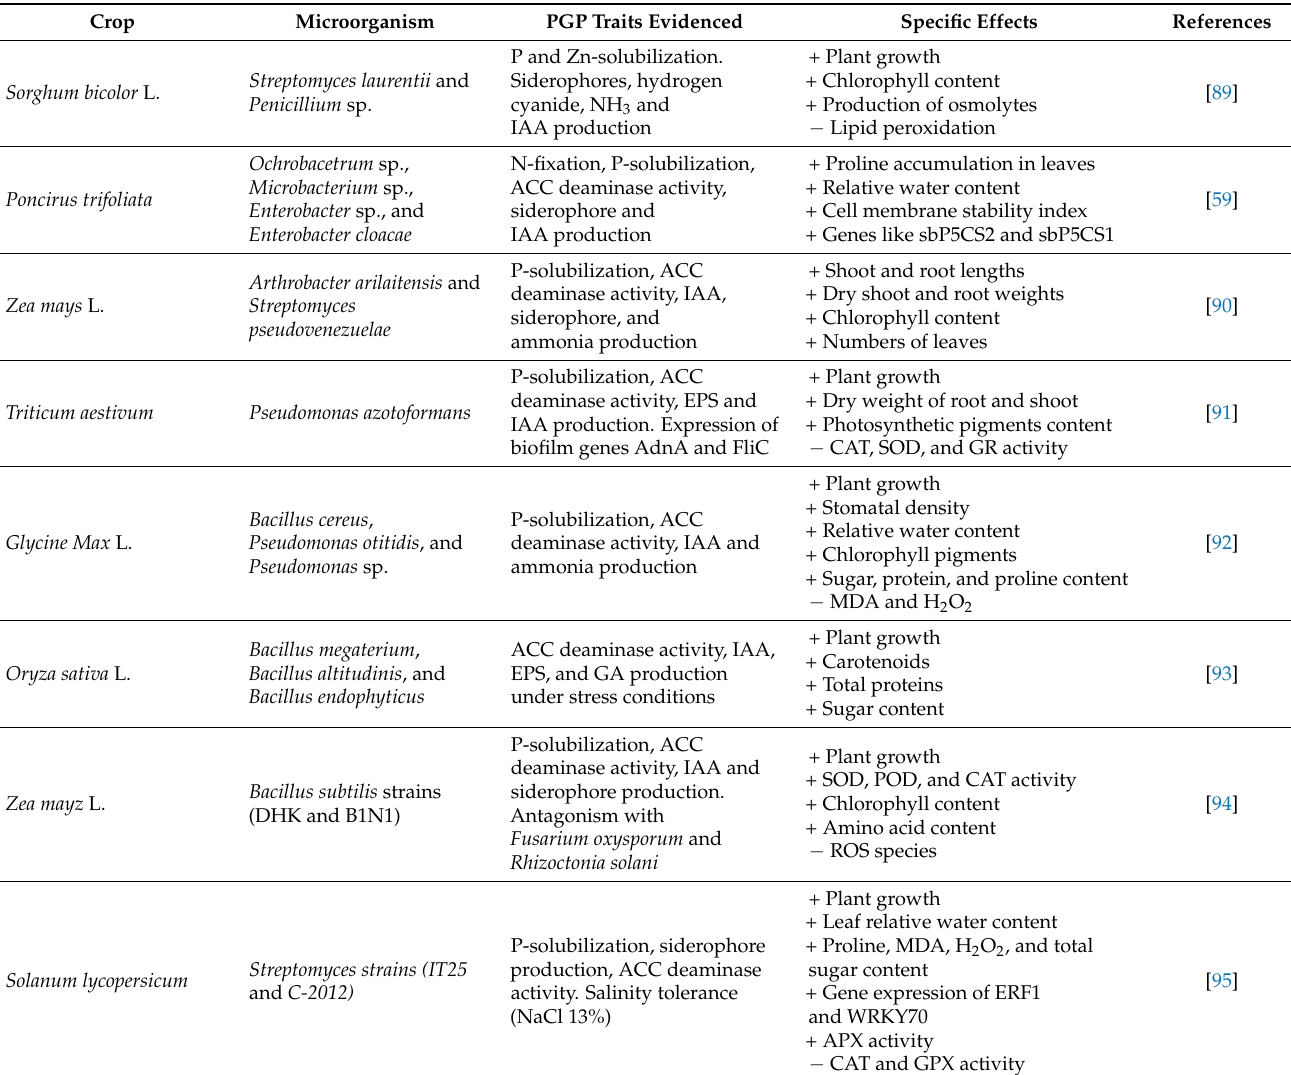
Table 1. Recent research (2020–2022) of plant growth-promoting (PGP) bacteria and their effects on plants growing under drought